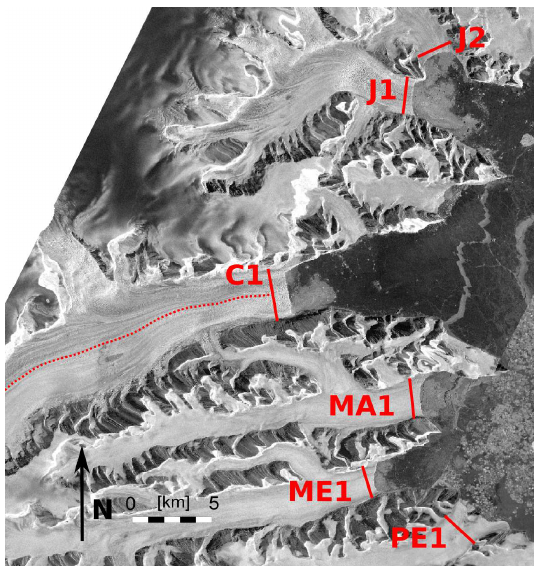
Figure 4. TerraSAR-X image of Antarctic Peninsula glaciers draining into the central Larsen- Fig. 4. TerraSAR-X image of Antarctic Peninsula glaciers draining into the central Larsen-B embayment, acquired on 18 October 2008, B embayment, acquired on 18 October 2008 , with gates for mass fluxes as specified in Table with gates for mass fluxes as specified in Table 2. The dotted line 2. The dotted line shows the position of the longitudinal profile in Fig. 5. shows the position of the longitudinal profile in Fig. Fig. 3. TerraSAR-X image of Antarctic Peninsula glaciers drain- Figure 3. TerraSAR-X image of Antarctic Peninsula glaciers draining into the northern ing into the northern Larsen-B embayment, acquired on 18 October Larsen-B embayment, acquired on 18 October 2008 , with gates for mass fluxes as specified in 2008, with gates for mass fluxes as specified in Table 2.